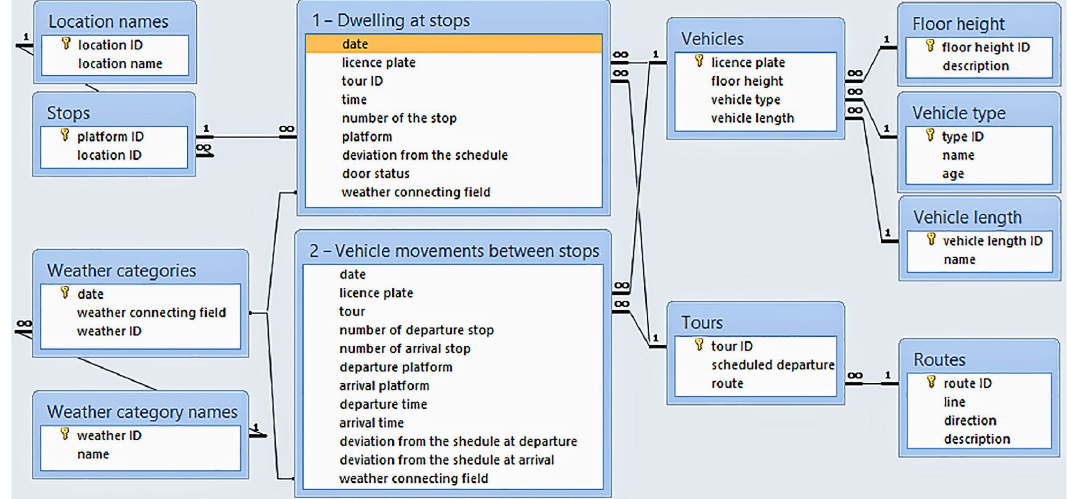
Fig. 1. Relational structure of the database ( source : research by the authors)